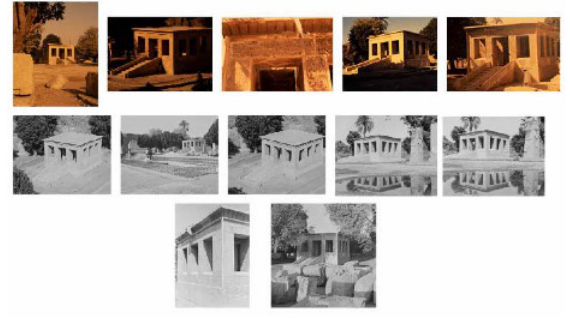
Figure 6 . The twelve photographs of the East and North facade.